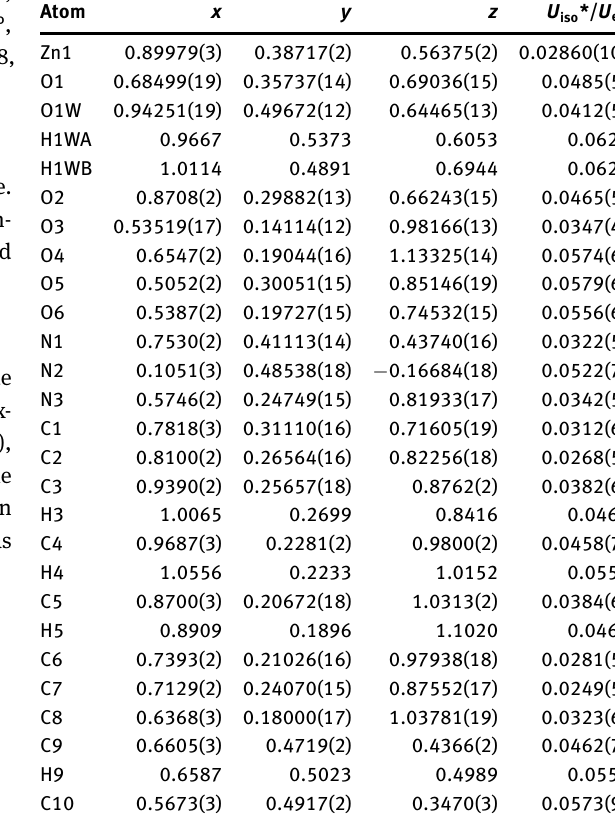
Table 2: Fractional atomic coordinates and isotropic or equivalent isotropic displacement parameters (Å 2